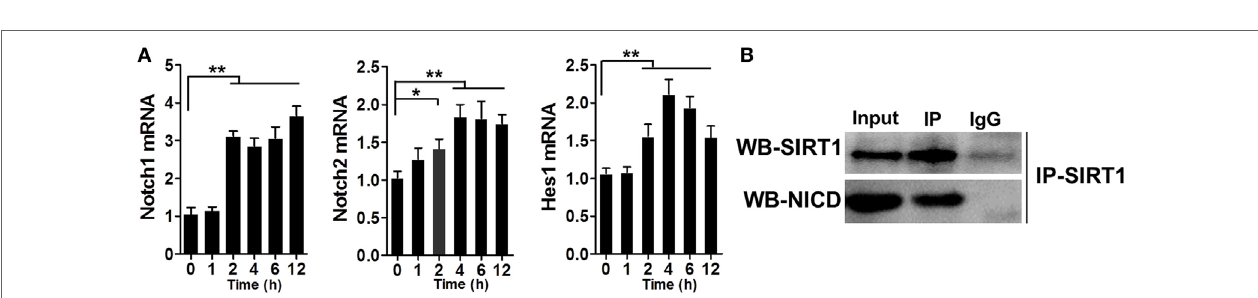
FigUre 4 | Lipopolysaccharide (LPS)-stimulated inflammation was exacerbated in sirt1 − / − macrophages. Wild-type (WT) and sirt1 − / − macrophages were treated with LPS or PBS (NT), and then RT-PCR was used to assess the levels of IL-1 β , IL-6, TNF- α , CCL2, and NOS2. **p < 0.01 compared with the LPS + WT group; n = 6.